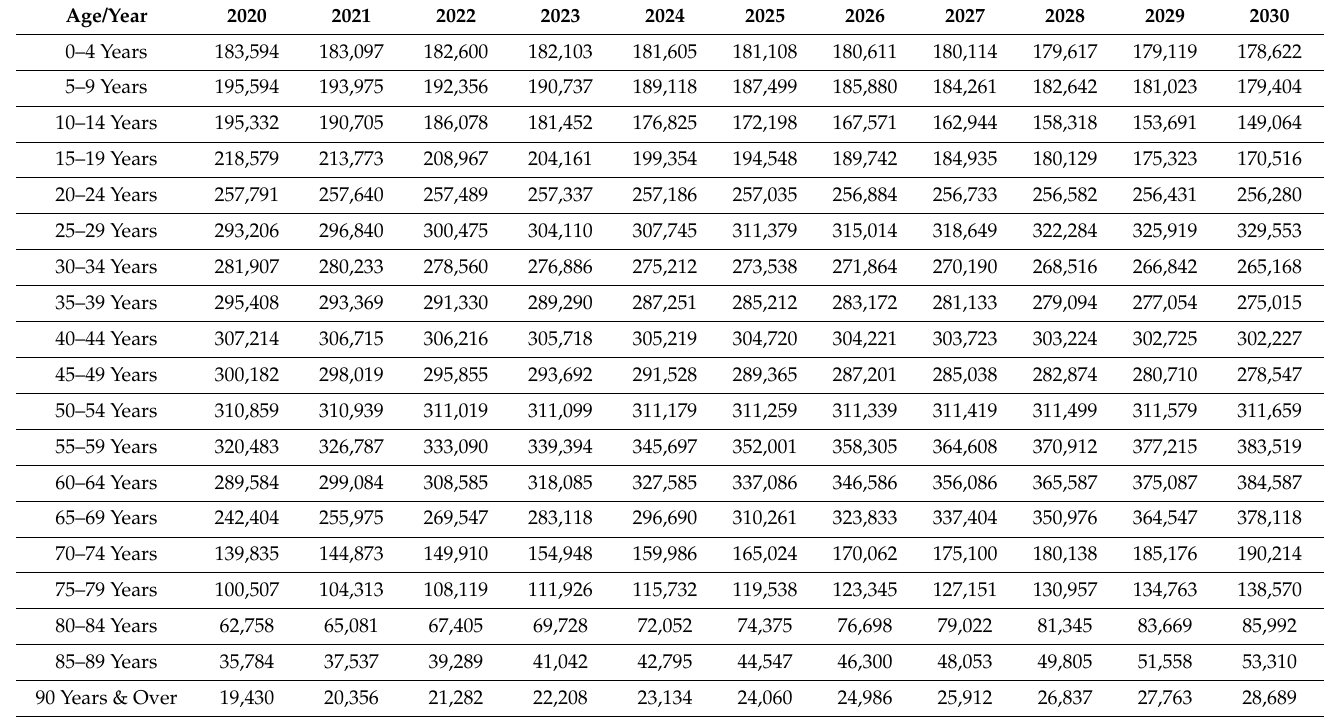
Table 3. Projection of Singapore Residents by Age Group: 2020 to 2030.